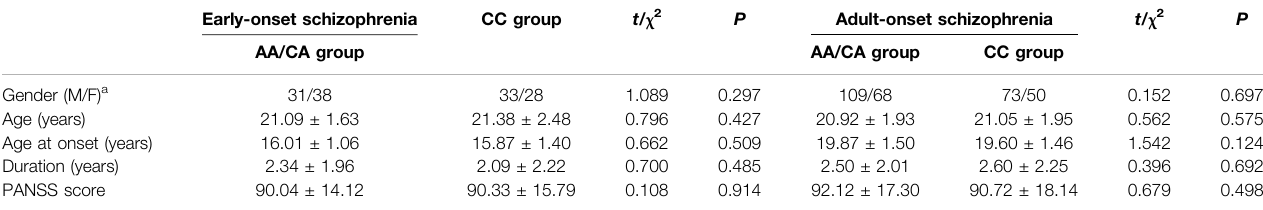
TABLE 1 | Demographic and clinical characteristics of patients with early-onset schizophrenia in two groups of NKAPL rs1635 genotype.